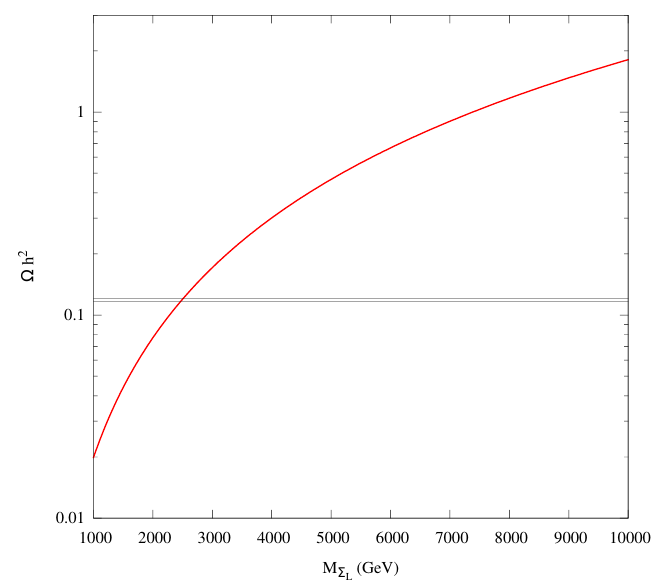
Figure 6 . The relic abundance of left fermion triplet dark matter as a function of its mass. The black horizontal band correspond to (cid:10) DM h 2 = 0 : 1187